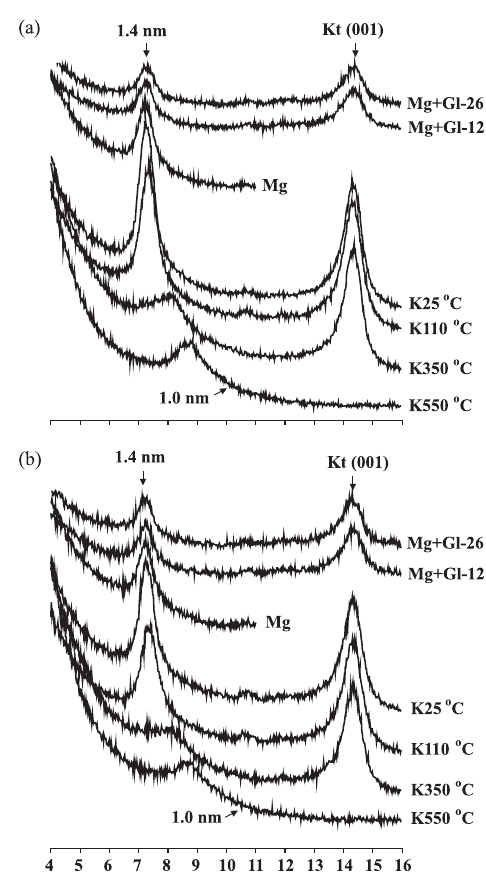
Figure 1. X-ray diffractograms of the clay fraction of soil under conventional tillage (a) and no- tillage (b) without the treatment with sodium citrate. Mg: saturation by magnesium; Mg+Gl- n o : saturation by magnesium followed by solvation with glycerol for 12 and 26 days; Kn o o C: saturation by potassium and respective thermal treatments; Kt: kaolinite. Scale in degrees ( o 2 ΘΘΘΘΘ